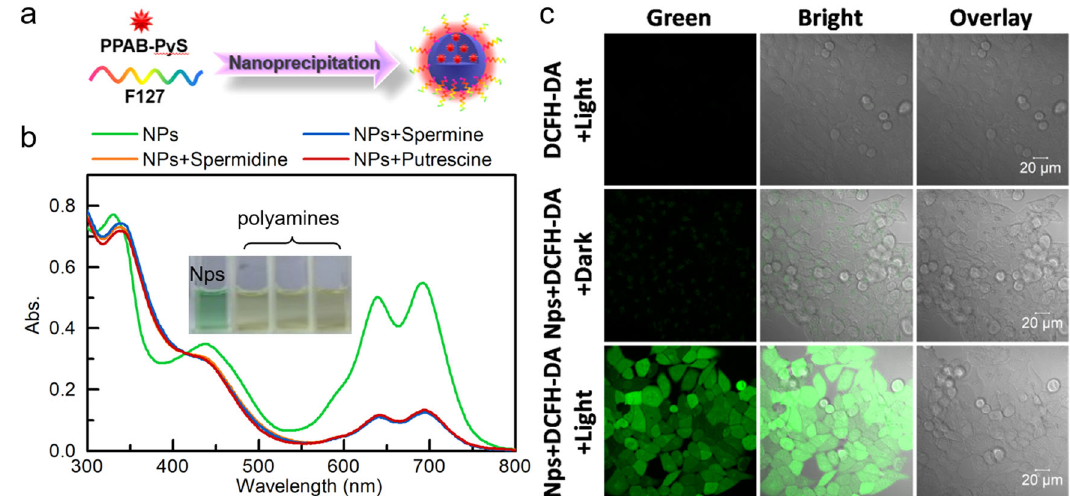
Fig. 4 The detection of intracellular ROS generated by PPAB-PyS NPs. a The formation of PPAB-PyS NPs. b The UV – vis spectra of PPAB-PyS NPs in presence of polyamines (inset: the color change in a presence of polyamines). c Intracellular ROS detection using DCFH-DA (10 μ M, 30 min) as an indicator in HeLa cells after PPAB-PyS NPs (50 μ M) under white light (30 mW/cm 2 ) irradiation for 30